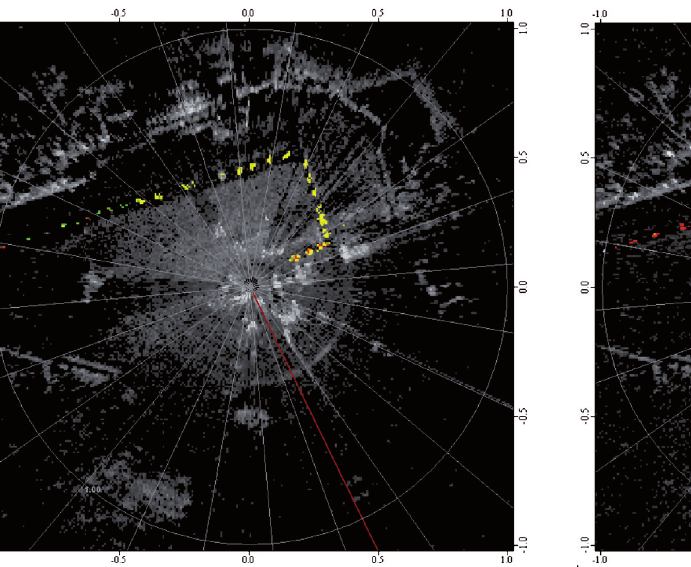
Fig. 3. The radar image of part of the airport area with an Antonov-140 plane moving along the taxiway and the runway